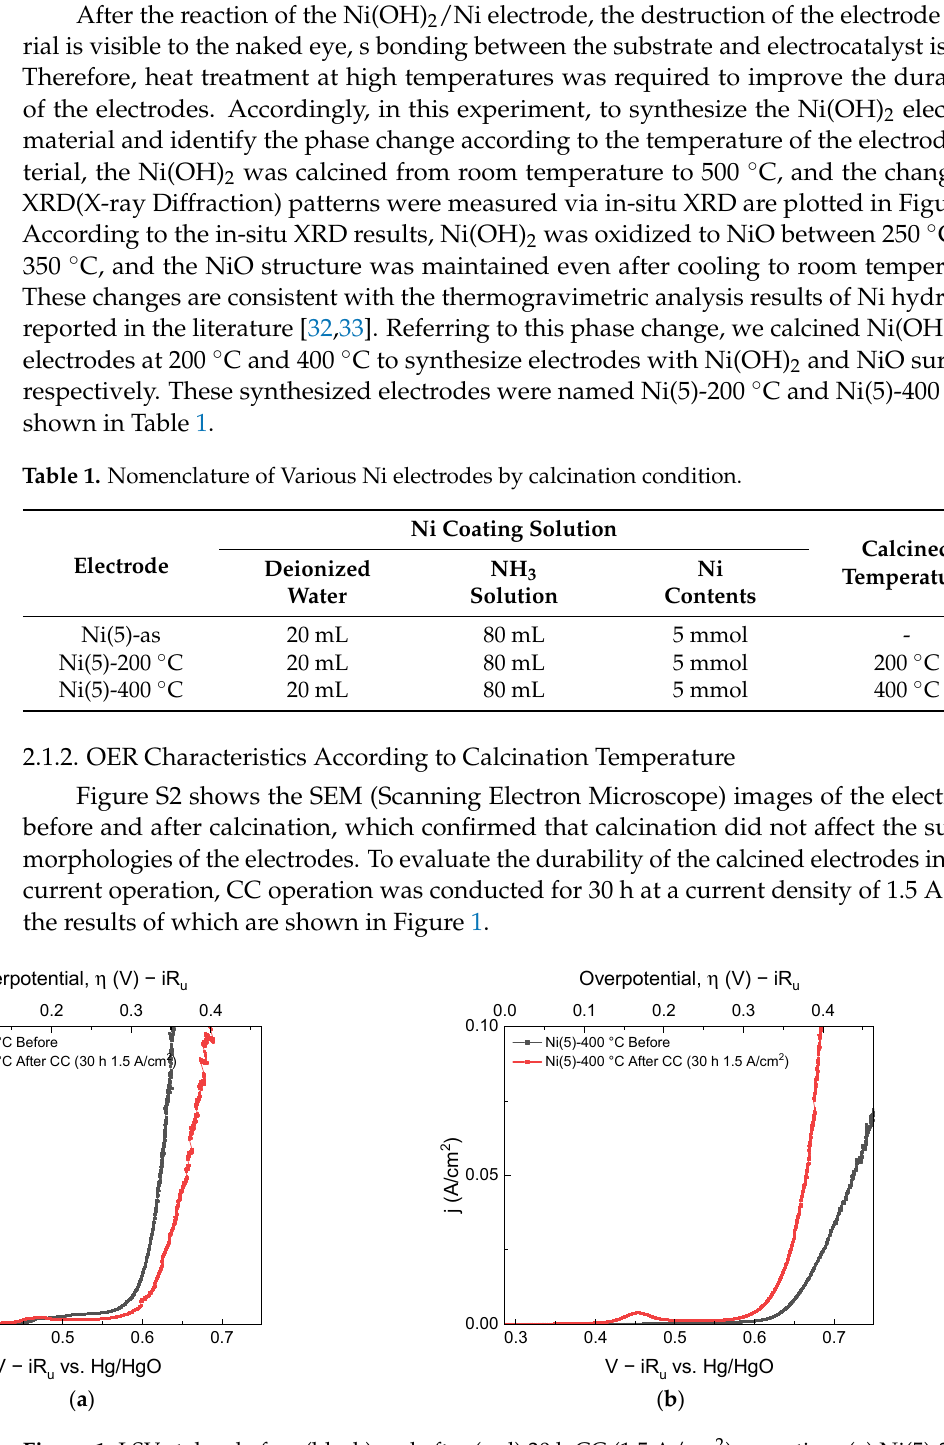
Figure 1. LSVs taken before (black) and after (red) 30 h CC (1.5 A/cm 2 ) operation: ( a ) Ni(5)-200 ◦ C and ( b ) Ni(5)-400 ◦